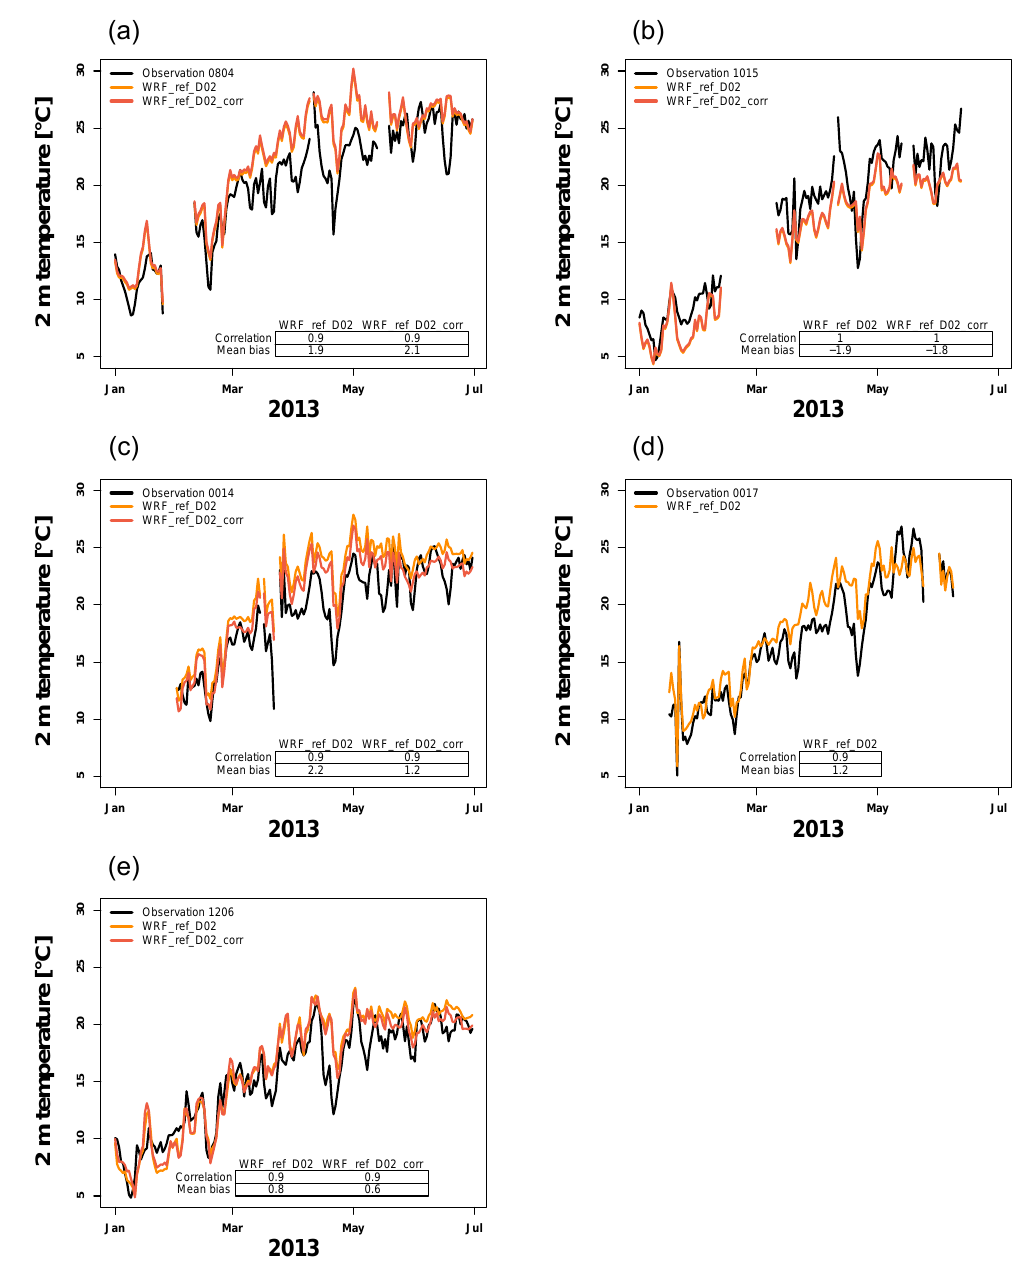
Figure 5. Time series of measured, simulated (WRF_ref_D02) and simulated but height-corrected (WRF_ref_D02_corr) daily mean 2m temperature ( ◦ C) during January–June 2013 at stations 0804 (a) , 1015 (b) , 0014 (c) , 0017 (d) and 1206 (e) . The tables in the subfigures give the temporal correlation and the mean bias between simulated and measured values ( ◦